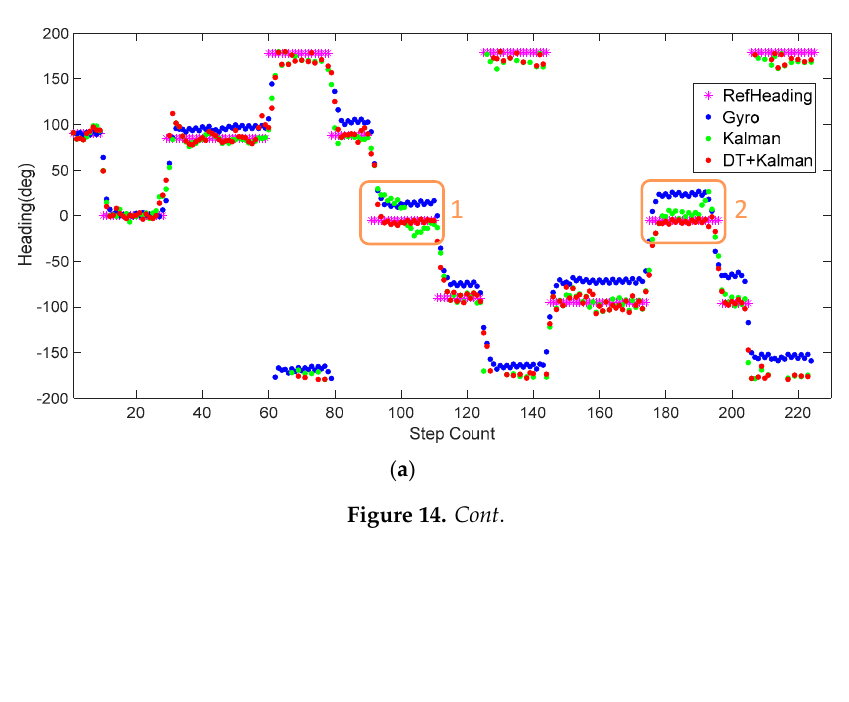
Figure 13. Magnetic data classification results generated by the decisions for indoor pedestrian inertial navigation. The red points are used to mark the interference measurements.